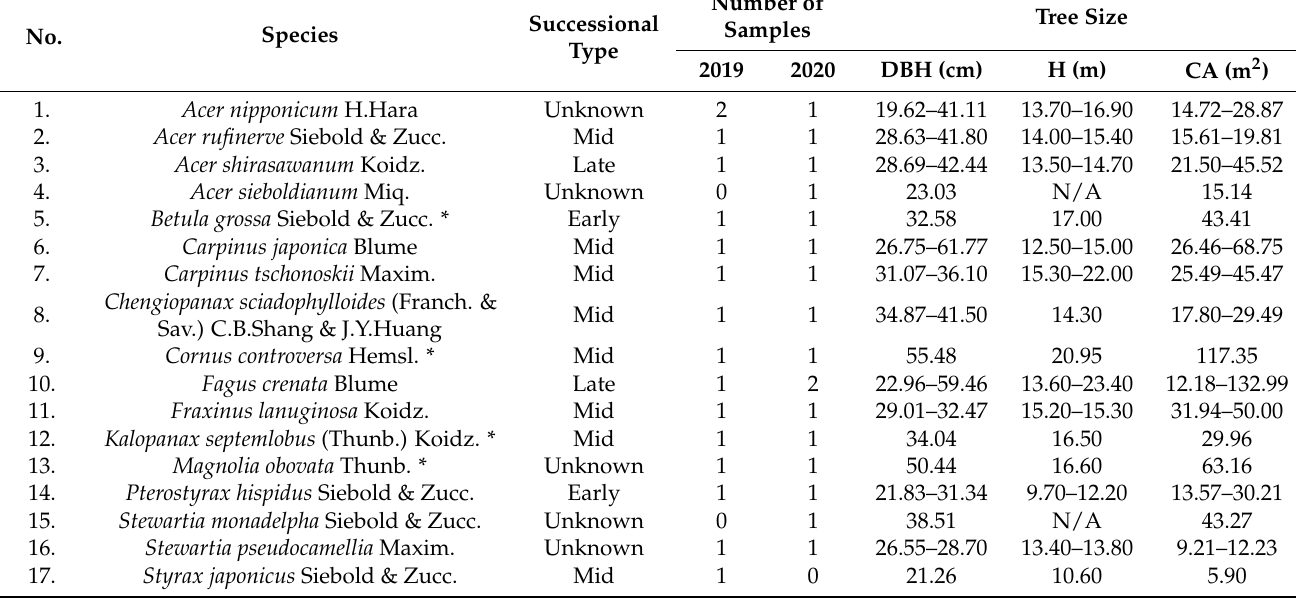
Table 1. List of species used in this study, including the tree size and successional type. Asterisks indicate the tree sample that was continually used for two years. The successional type was deter- mined based on the regeneration status of seedlings in the canopy gaps at the study plot (personal observation) and the data for shade tolerance provided by Niinemets and Valladares [32]. Species for which regeneration status could not be confirmed were classified as “Unknown”. Abbreviations: DBH, diameter at breast height; H, tree height; CA, crown projection